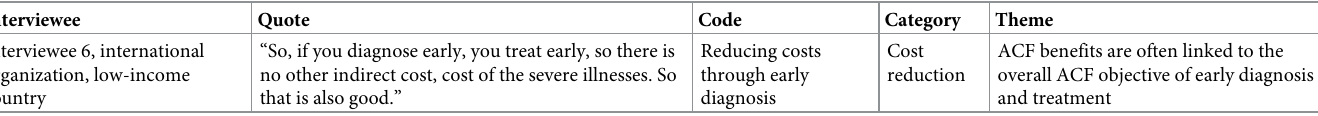
Table 2. Example of the coding